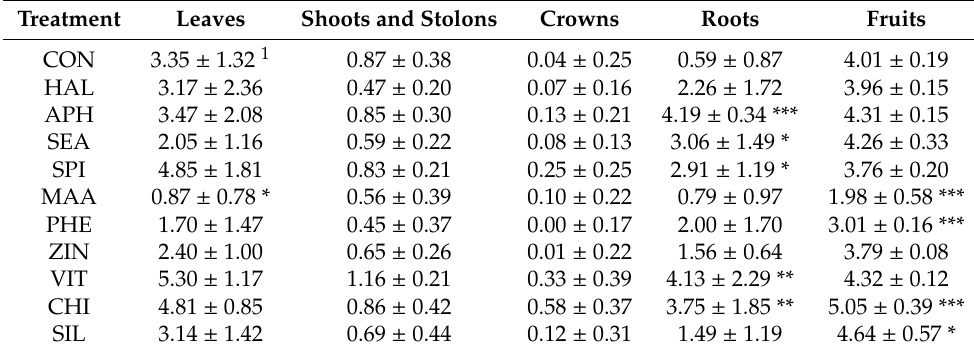
indicate absence of any significant di ff erences. Treatments legend: CON, control; HAL, humic acids; APH, alfalfa protein hydrolysate; SEA, macroseaweed extract; SPI, microalga hydrolysate; MAA, mix of amino acids; PHE,